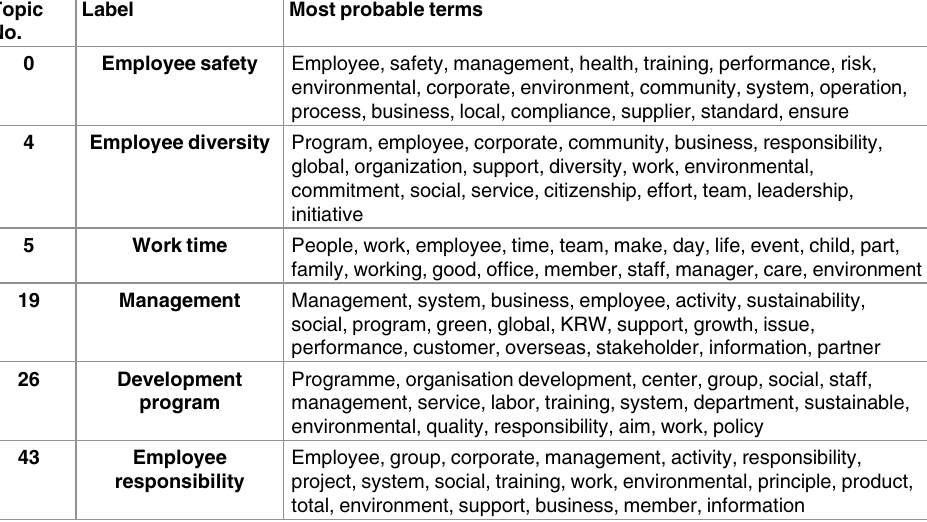
Table 4. Social sustainability topics concerned with employees including most probable occurring terms ordered by their probability. Topic